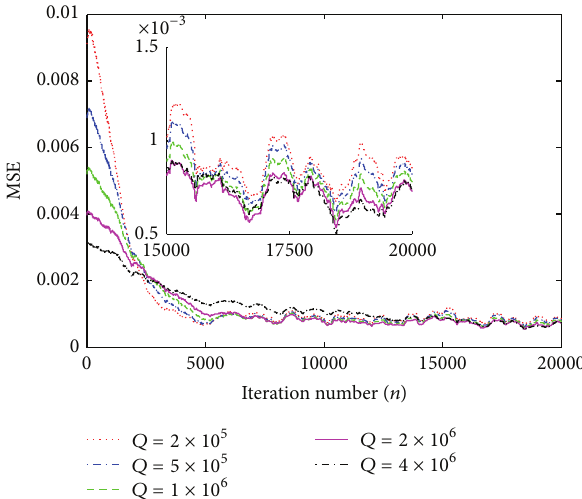
Figure 15: The MSE using the hybrid control under different phase errors of the cancellation path.